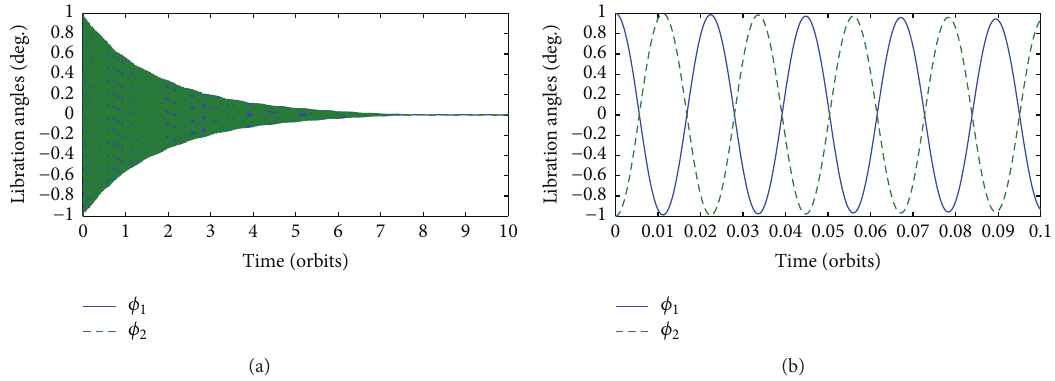
Figure 18: Libration angles from the formulations based on point 𝐴 by applying the SDRE control with 𝛼 = 10 −6 for (a) the first 10 orbits and (b) the first 0.1 orbits.